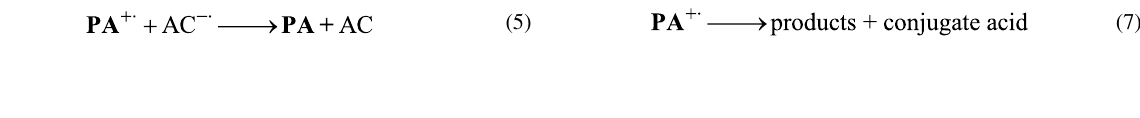
Table 1: Summary of structure elements of absorbers related to the structural patterns I – V . Table 2 summarizes their photophysical data. FEW Chemicals GmbH provided samples for the